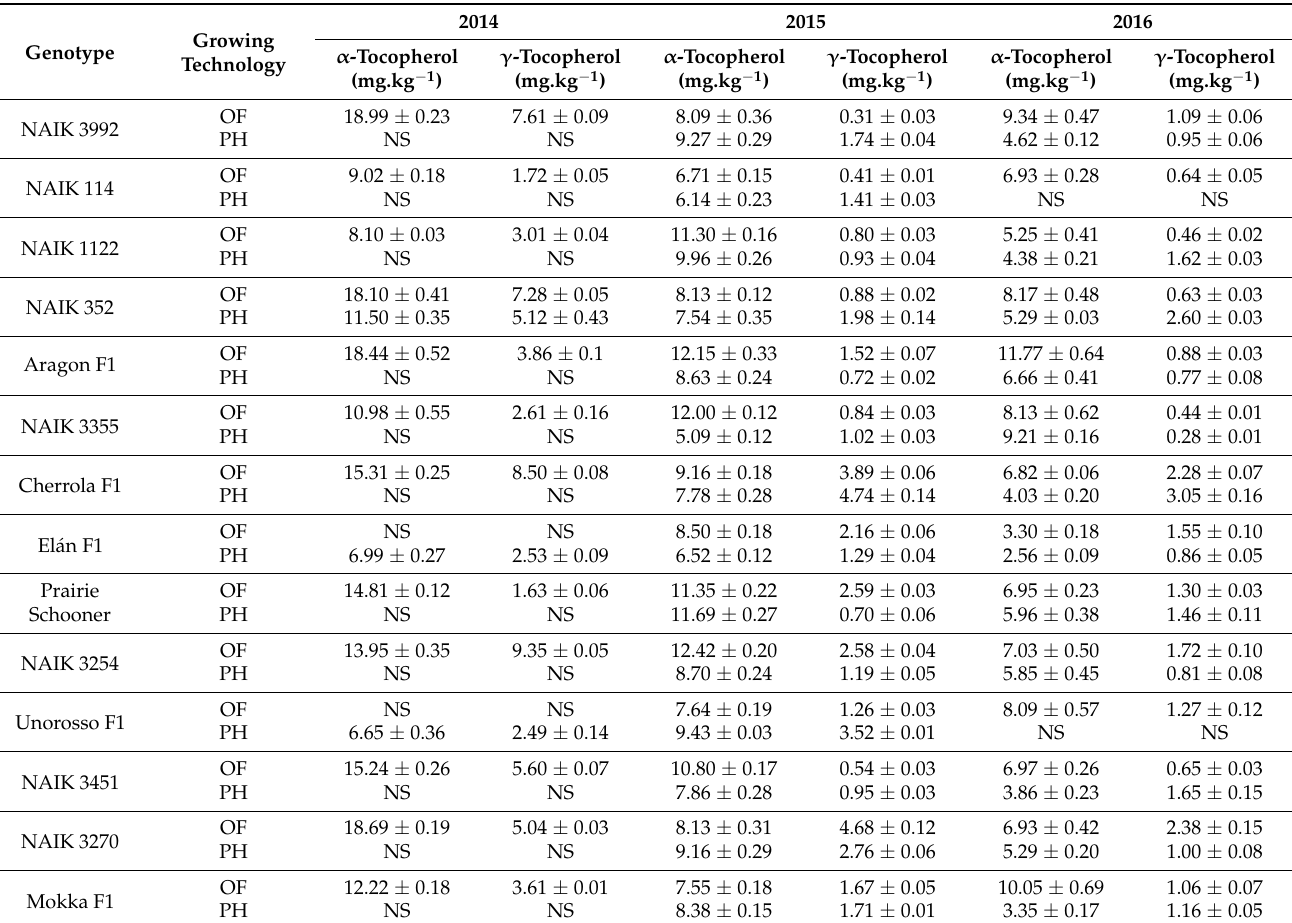
thesis of tocopherols in tomato. The level of α -tocopherol increased during ripening in all tissues, though its increase was largest between light red to red stages. Based on the data found in the literature, the amount of α -tocopherol in tomatoes varies between 2 and 14.7 mg.kg − 1 [39–42], which agrees with the values found in the examined varieties. During the 3-year study, the α -tocopherol content varied between 2.56 and 18.99 mg.kg − 1 fwt, while γ -tocopherol content varied between 0.28 and 9.35 mg.kg − 1 in fresh tomato fruit. The variety NAIK3992 contained the highest amount of all tocopherols (26.6 mg.kg − 1 fwt) in 2014, the variety NAIK 3254 in 2015 (15.01 mg.kg − 1 fwt), and the variety Aragon F1 in 2016 (12.42 mg.kg − 1 fwt) (Table 2). Table 2. The α - and γ -tocopherol concentration in tomato samples during 2014–2016 under different growing technology (NS—no samples; OF—open field; PH—plastic